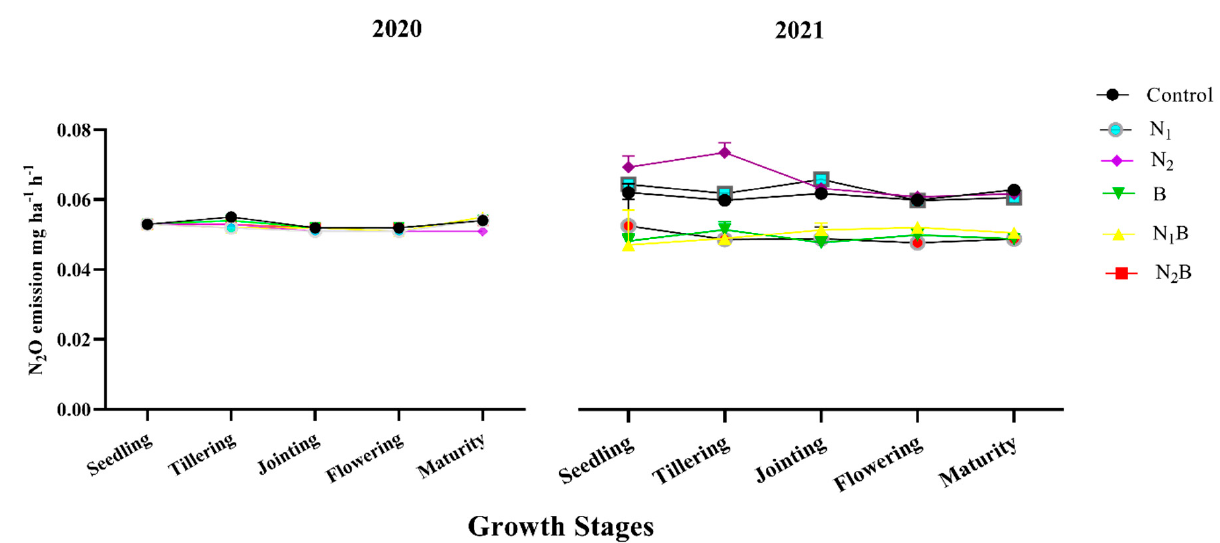
Figure 3. Direct effect of biochar on N 2 O emissions at different growth stages of spring barley (2020) and after effects on pea crop (2021). Treatments: control-without amendments; N 1 -160 kg ha − 1 nitrogen fertilizer; N 2 -120 kg ha − 1 nitrogen fertilizer; B-25 t ha − 1 biochar; N 1 B-160 kg ha − 1 nitrogen fertilizer plus 25 t ha − 1 biochar; N 2 B-120 kg ha − 1 nitrogen fertilizer plus 25 t ha − 1 biochar.